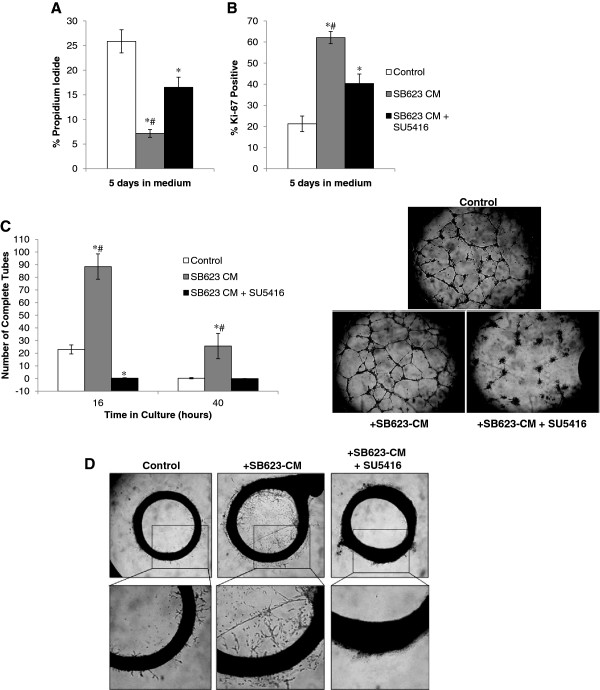
Treatment with 50nM SU5416 reduces angiogenic potency of SB623 cell -conditioned medium. Following “starvation”, HUVECs were treated with SB623-CM with or without SU5416 for 30 minutes prior to culture to assess the role of VEGF in different steps of angiogenesis. The negative controls were cultured directly in OptiMEM. A and B) Cell death and cell proliferation were assessed after 7 days in culture by staininig for propidium iodide and Ki67, respectively. SB623 cell-CM significantly reduced cell death and increased proliferation (*p < 0.05 versus OptiMEM only control). However, this was partially reversed in the presence of SU5416 (#p < 0.05 SB623 CM versus SB623 CM + SU5416). C) HUVEC vascular tube formation was quantified at 16- and 40 hours after plating in RGF-basement gel. A representative phase contrast picture of vascular tube formation at 16 hours is shown here, revealing the reduction in complete tubes formed in the presence of SU5416 (p < 0.05 versus OptiMEM only control; #p < 0.05 versus SB623 CM + SU5416). D) Aortic rings were likewise pre-treated with or without SU5416 for 30 minutes prior to embedding in RGF gels with SB623-CM. The control aortic ring well was not pre-treated with SU5416 and was maintained in RGF-basement gel in OptiMEM. It is clear that in the presence of SU5416 there is no aortic sprouting. Plots show Mean ± SD.